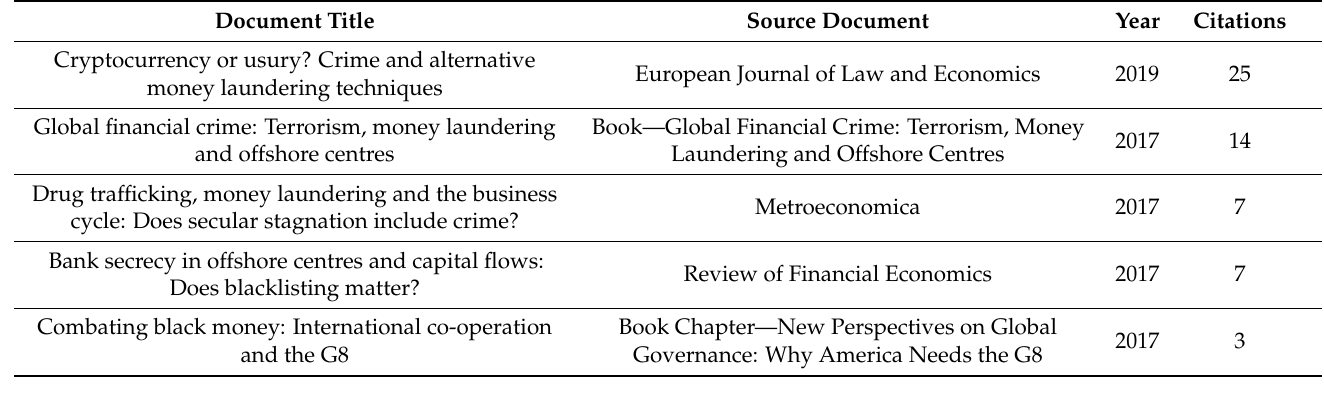
Table 11. Masciandaro—scholarly output and citations, 2017 to 2022.